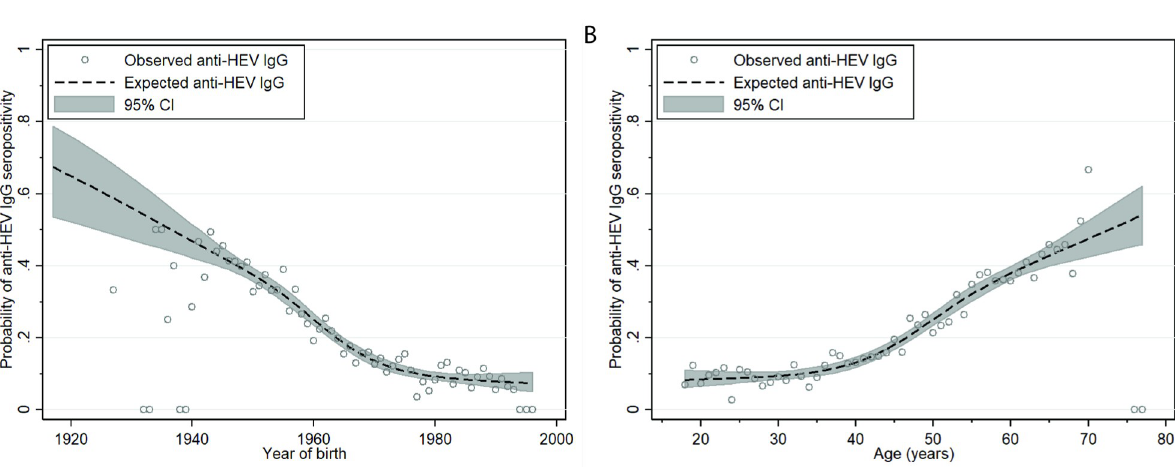
PLOS ONE | https://doi.org/10.1371/journal.pone.0208522 December17,